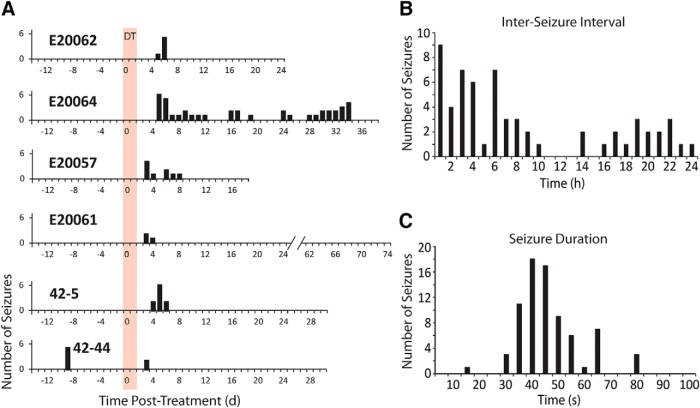
SRSs after interneuron ablation generally occur during a limited time period. A, Daily seizure activity is plotted for two weeks of baseline recording beginning with virus transfection and transmitter implantation. This was followed by continuous recording through the DT treatment period (shown to start at day 0, and lasting for 2 d, red bar) and beyond for several weeks for each mouse. SRSs were seen primarily in the first week after ablation. E20057 had nine seizures spanning from day 3 to day 8; four were confirmed to be convulsive (level 3 or higher). E20061 had three convulsive seizures (two level 3 and one level 5) on days 3-4. E20062 had a total of six seizures over a time period of ∼9 h. Seizures began just before the start of day 6 (11:33 P.M. on day 5); two were convulsive (level 4), four were nonconvulsive (level 2). E20064 had a total of 41 seizures that began on day 5; the first nine seizures were nonconvulsive (level 2), they then progressed to convulsive seizures (level 3-5). 42-5 had 10 seizures on day 4 to day 6; eight were confirmed nonconvulsive (level 2). 42-44 had two seizures on day 3; video from this day was either corrupt or missing. B, Interseizure interval is plotted for all seizure intervals ≤24 h for all mice. The histogram demonstrates that seizures were not confined to brief intervals, thus demonstrating that the interneuron-ablation treatment did not produce a discreet period of SE. C, The histogram of seizure durations illustrates that SRSs induced by interneuron ablation typically had a duration of 30-65 s.